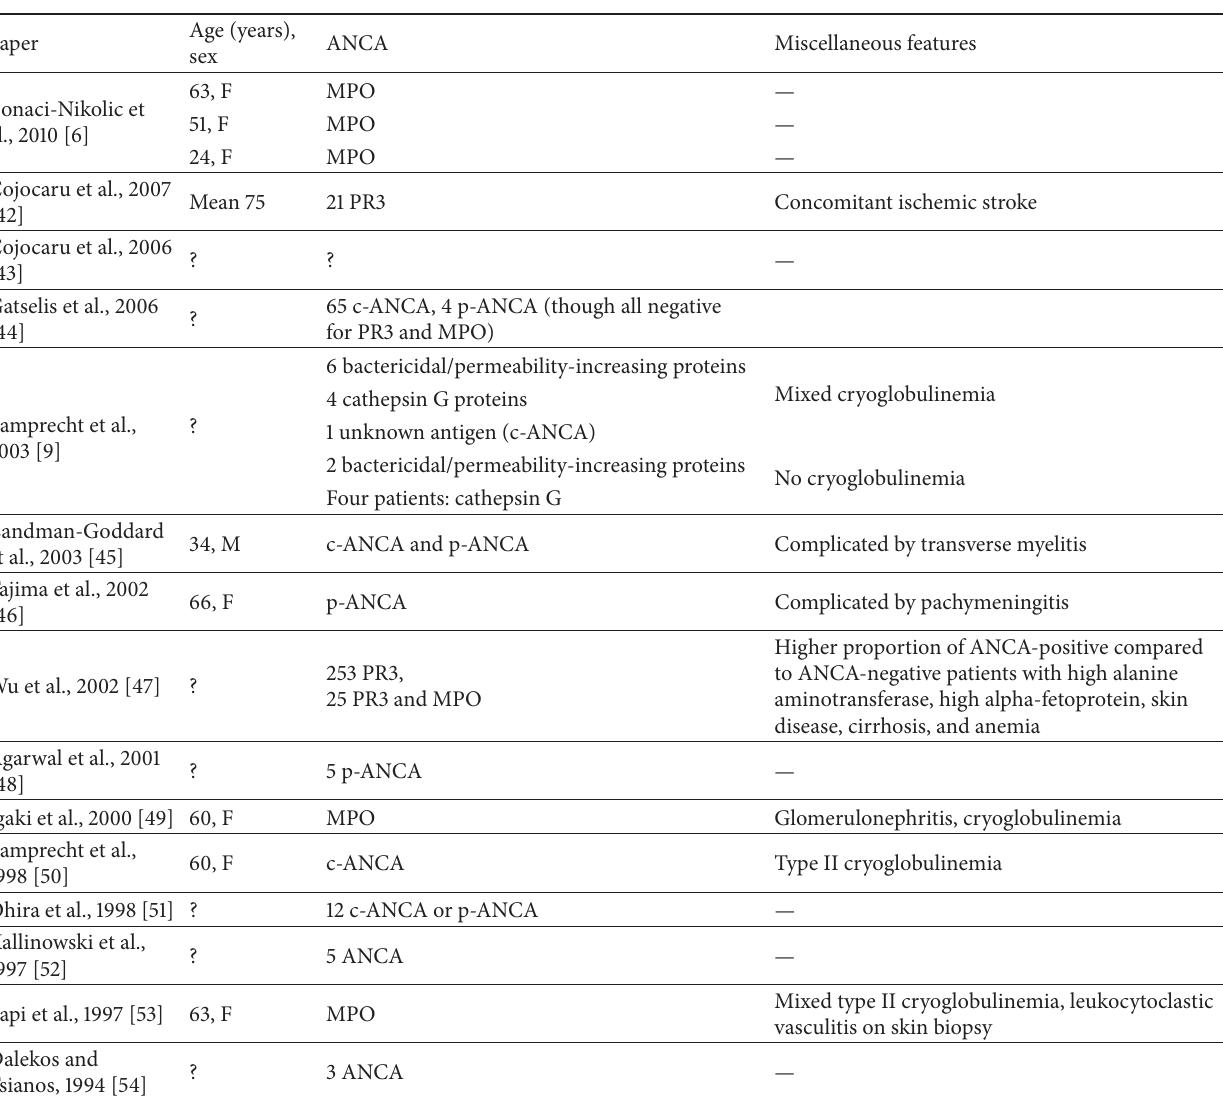
Table 3: Summary of previously published ANCA-positive hepatitis C infection